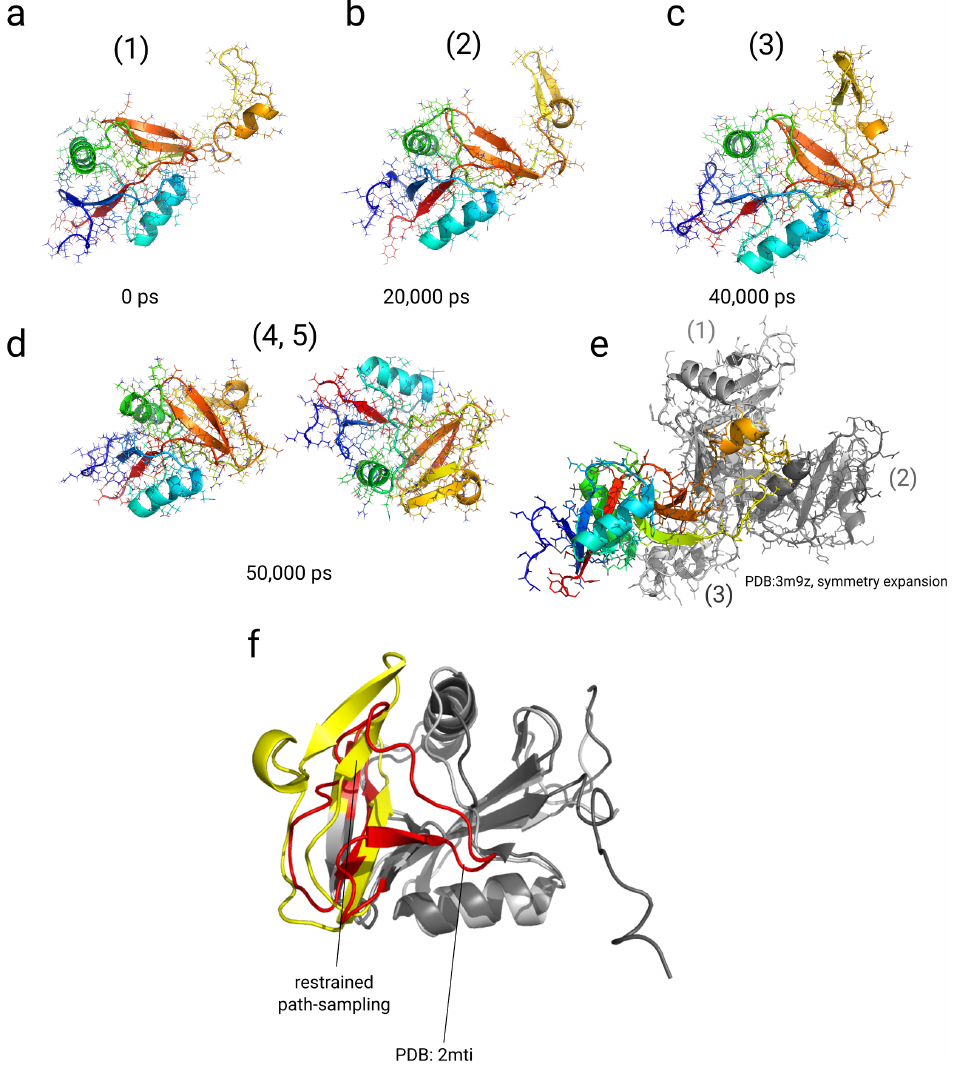
Figure 6. Results from restraint multiple path-sampling simulations of the Killer Cell Lectin-like Receptor Subfamily B Member 1A (NKR-P1A) using chemical cross-linking restraints from ref. [89] in explicit solvent (PDB: 3m9z as starting structure). Conformations at different stages of the restrained simulation (0 ps ( a ), 20,000 ps ( b ), 40,000 ps ( c ), and 50,000 ps ( d )). ( e ) Symmetry expanded structure of the X-ray structure (PDB: 3m9z) with monomers in contact with the loop region (residues: Arg157-Ser188) of the protein. Monomer (1) (light grey) shares a contact with its 3 β -strands (residues: Tyr149-Ser201) with the loop region in the crystal structure. Monomer (2) (dark grey) is in contact with its second α -helix (Gln135-Lys146) with the loop region. ( f ) Structural overlay of NKR-P1A structure after 50 ns in the explicit restrained simulation (protein core in grey color, loop regions in yellow color) with the experimental NMR-structure (protein core in dark grey color, loop region in red color) (PDB: 2mti [118]). The RMSD C α − C α between the 2 structures equals 0.56